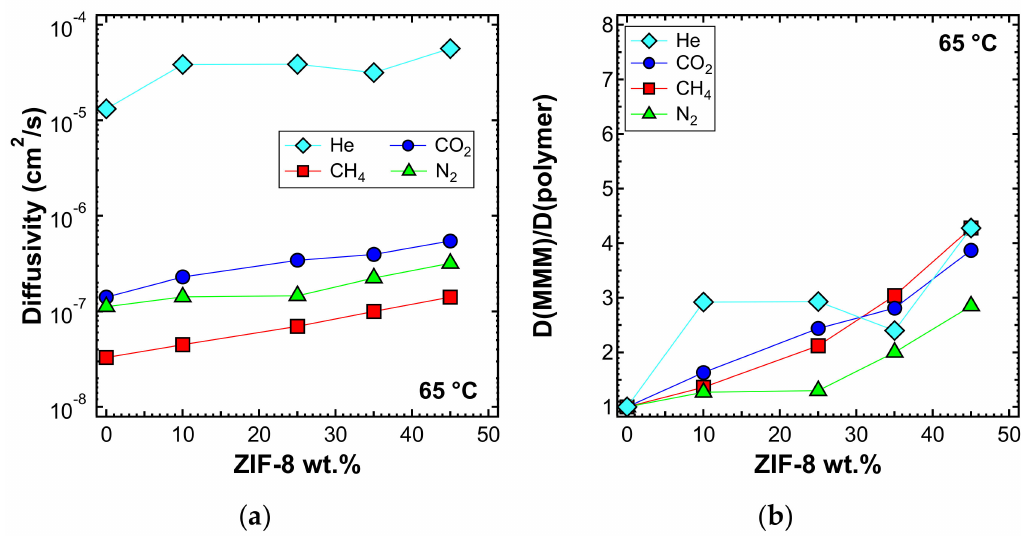
Figure 19. ( a ) Di ff usivity and ( b ) relative di ff usivity increase of various gases at 65 ◦ C in ZIF-8 / PPO MMMs, estimated with the time-lag